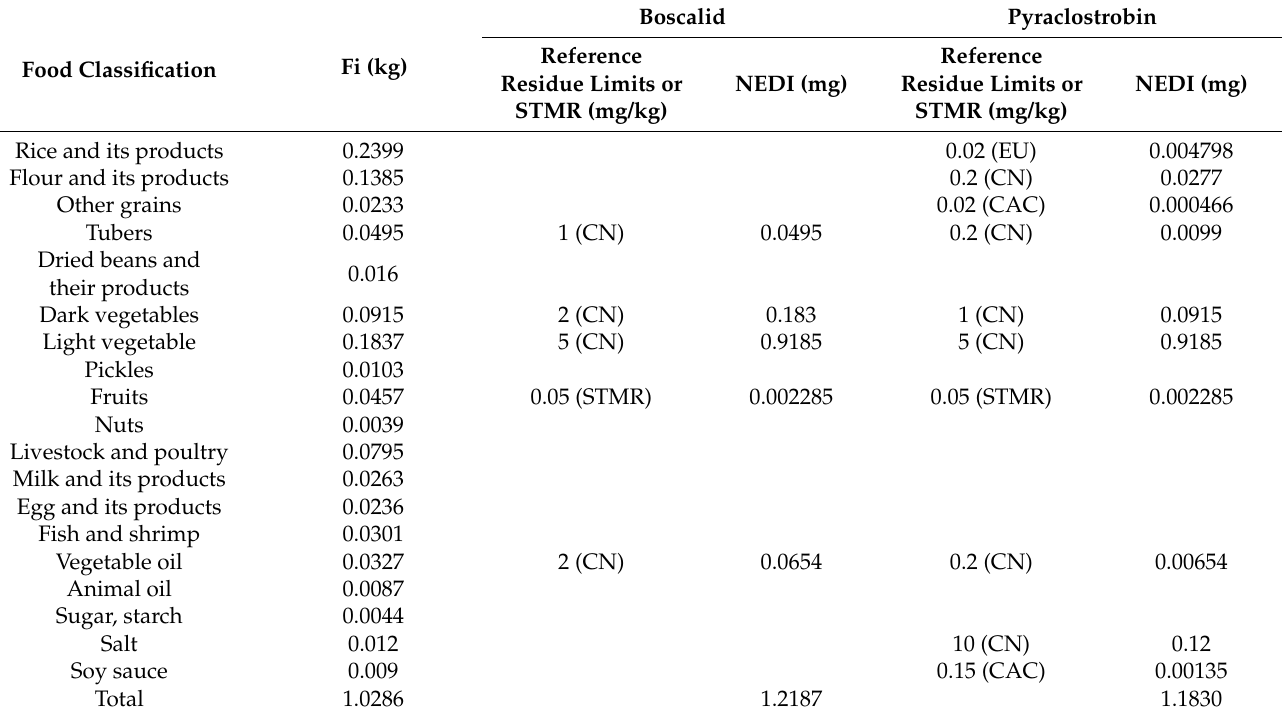
Table 5. The chronic dietary intake risk assessment of boscalid and pyraclostrobin in accordance with Chinese dietary